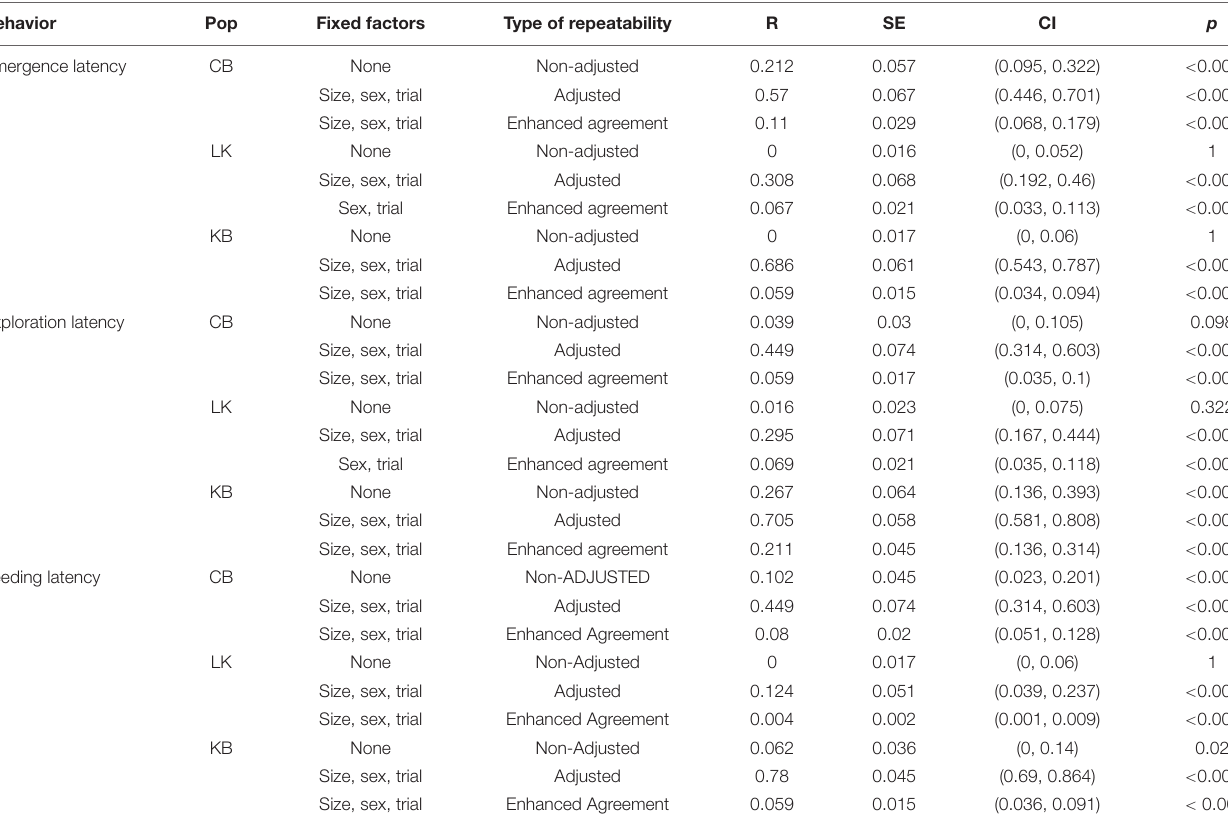
Standard errors (SE), 95% confidence intervals (CI), and p-values are provided. TABLE 8 | Repeatability for behaviors within populations with Fish ID as random factor.